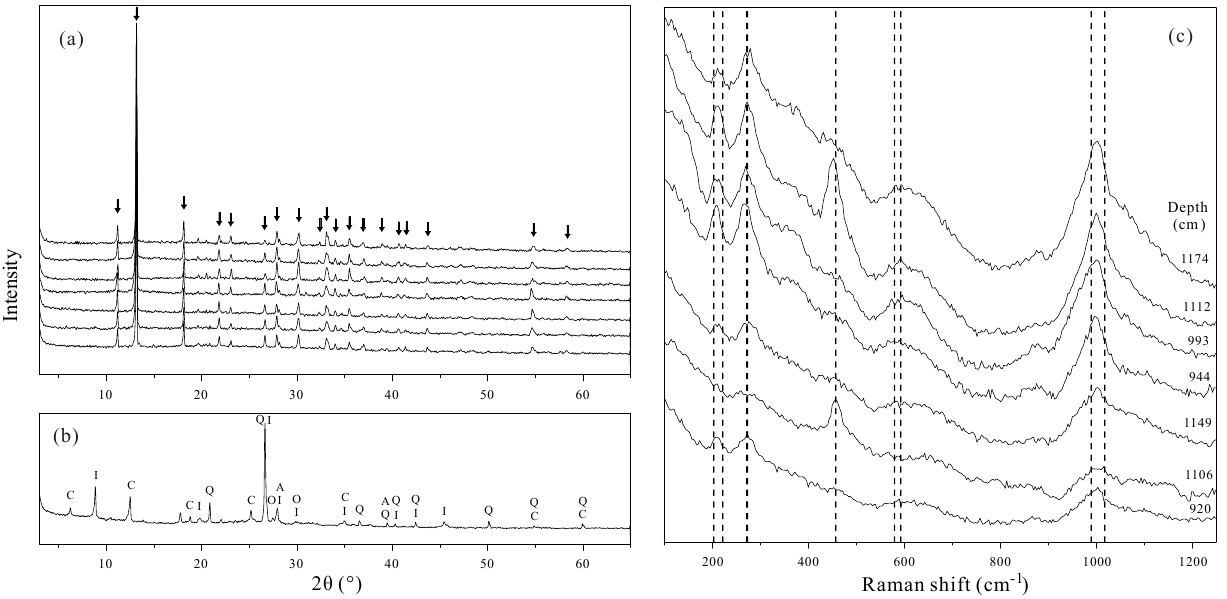
Figure 5. X-ray diffraction and Raman spectra of handpicked mineral aggregates. (a) XRD spectra of the blue to black mineral aggregates isolated from sediments from below the SMTZ. The spectra of samples from the top to the bottom correspond to samples taken at 920, 944, 993, 1106, 1112, 1149, and 1175cm depth, respectively. All the identified peaks highlighted by arrows belong to the vivianite reference spectrum. (b) XRD spectrum of the grey to green mineral aggregates obtained from sediments at 1281cm depth. I: illite, C: chlorites, Q: quartz, A: albite, O: orthoclase. (c) Raman spectra of the blue to black mineral aggregates from below the SMTZ. The dashed lines represent known vivianite spectral features (Piriou and Poullen, 1984).